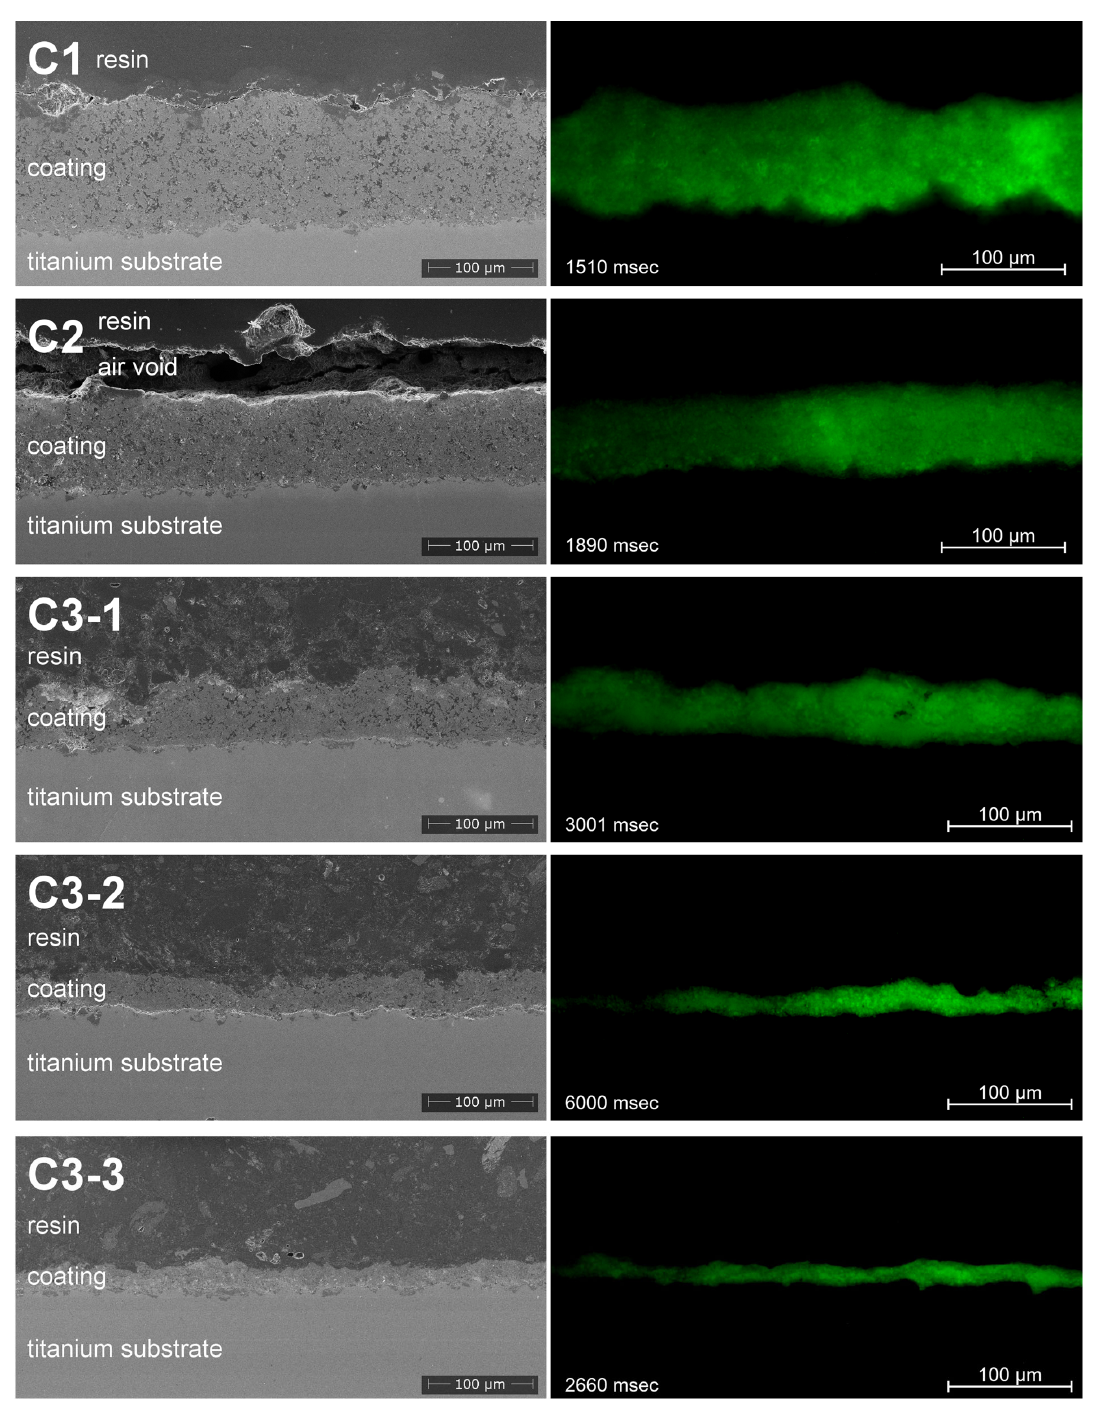
Figure 4. Coating microstructures investigated by SEM with SE detector at 5 kV acceleration voltage ( left column ) and fluorescence microscopy with FITC filter ( right column ).